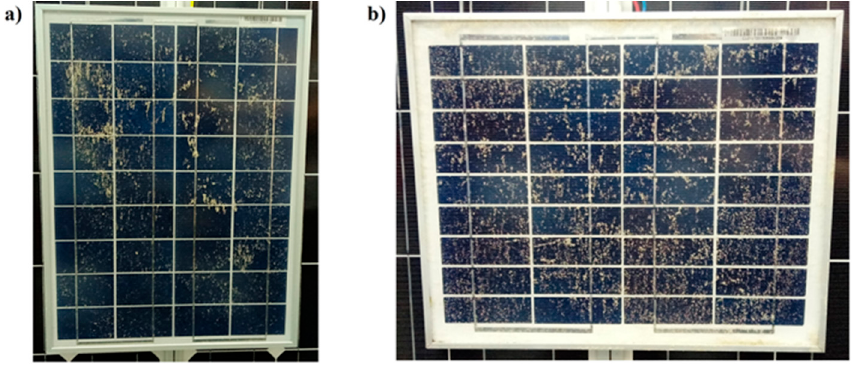
Figure 3. PV modules contaminated with around 13.2 g/m 2 dust density on their surface: ( a ) MWG-20, ( b ) CLC010-12P.